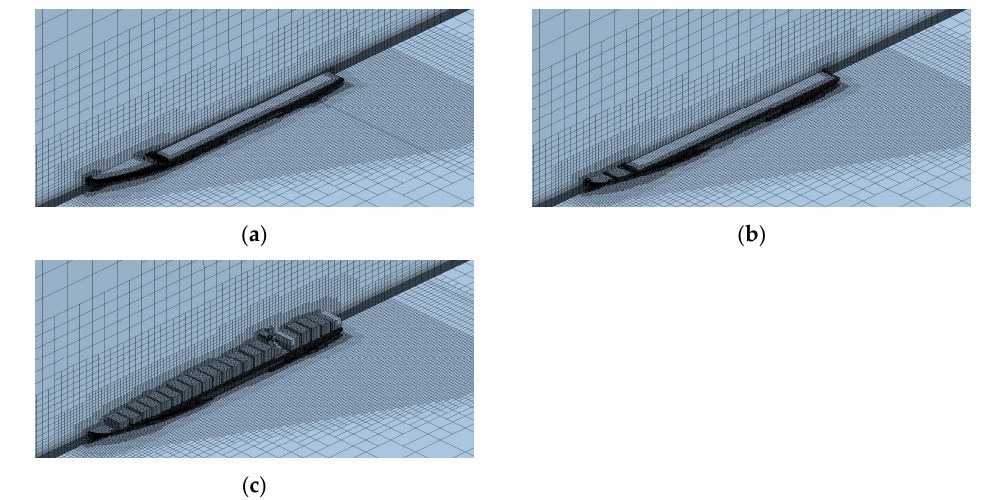
Figure 3. Grid system for numerical simulation. ( a ) KCS, ( b ) 8000 TEU-class container ship without superstructure, and ( c ) 8000 TEU-class container ship with superstructure.